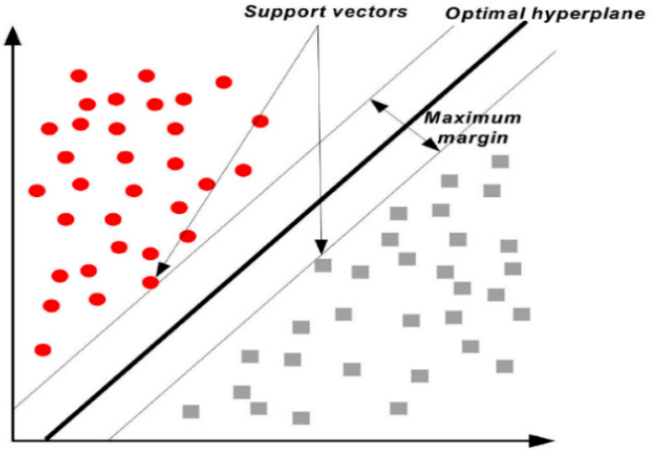
Figure 5. Conceptual diagram of the support vector machine (SVM).